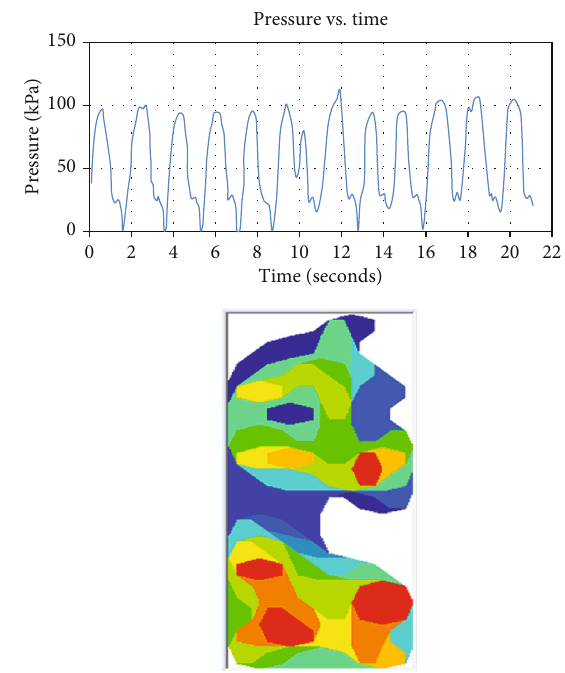
Figure 10: Pressure with time at the anterior region.